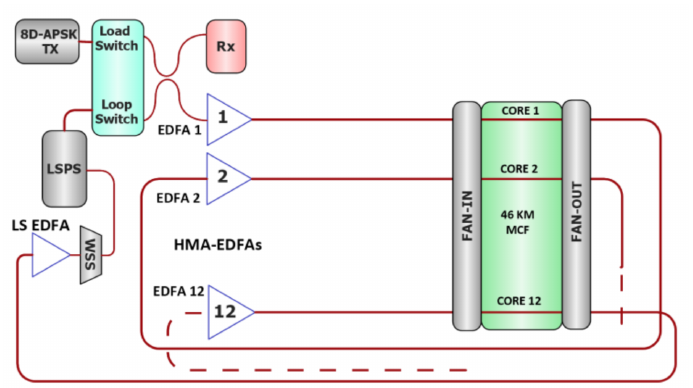
Figure 26. Schematic structure of circulating loop experiment composed of 12 EDFAs